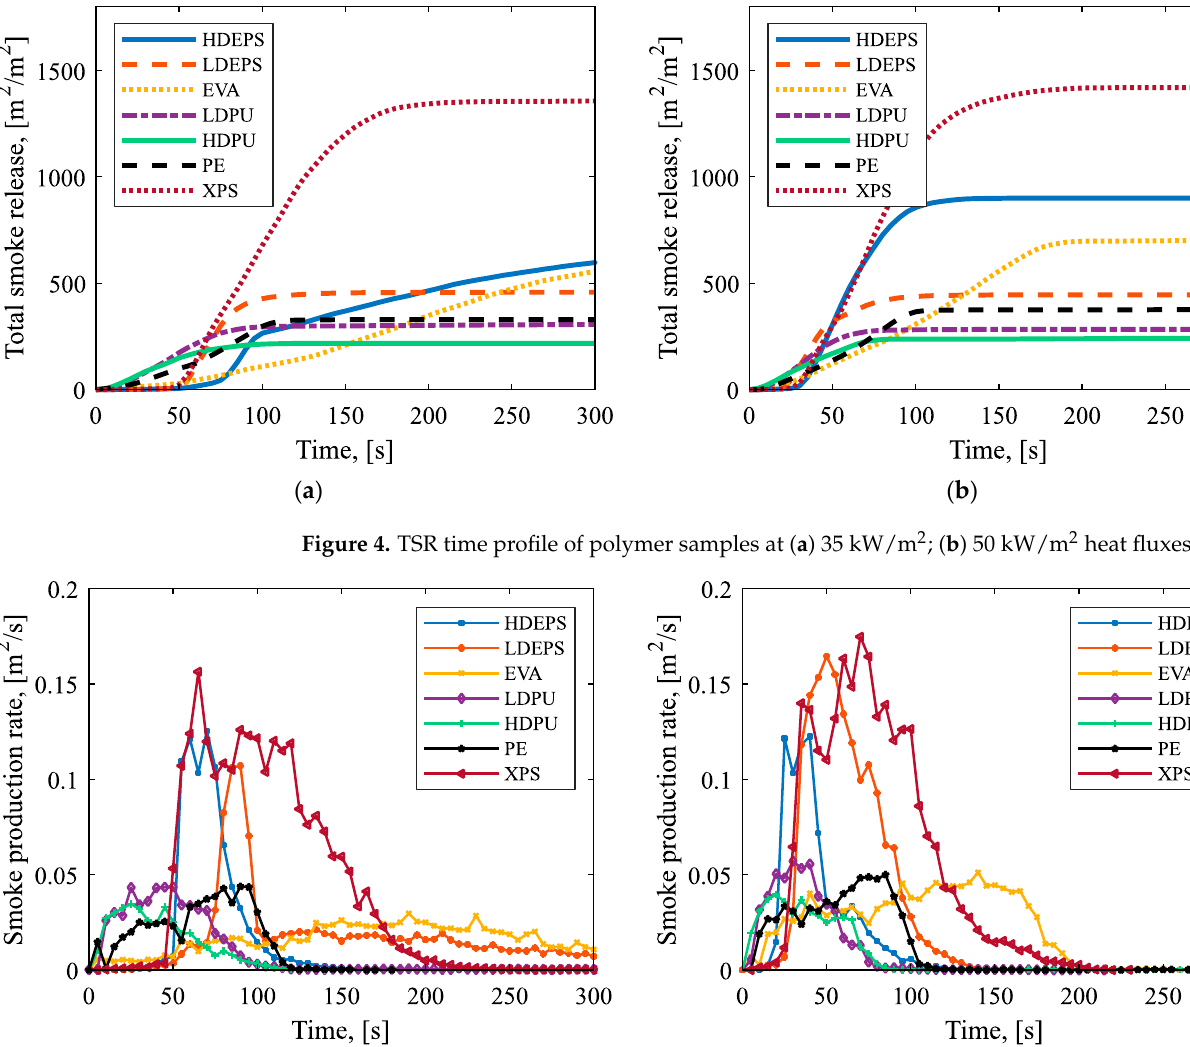
Figure 3. Mass loss time profile of polymer samples at ( a ) 35 kW/m 2 ; ( b ) 50 kW/m 2 heat fluxes.